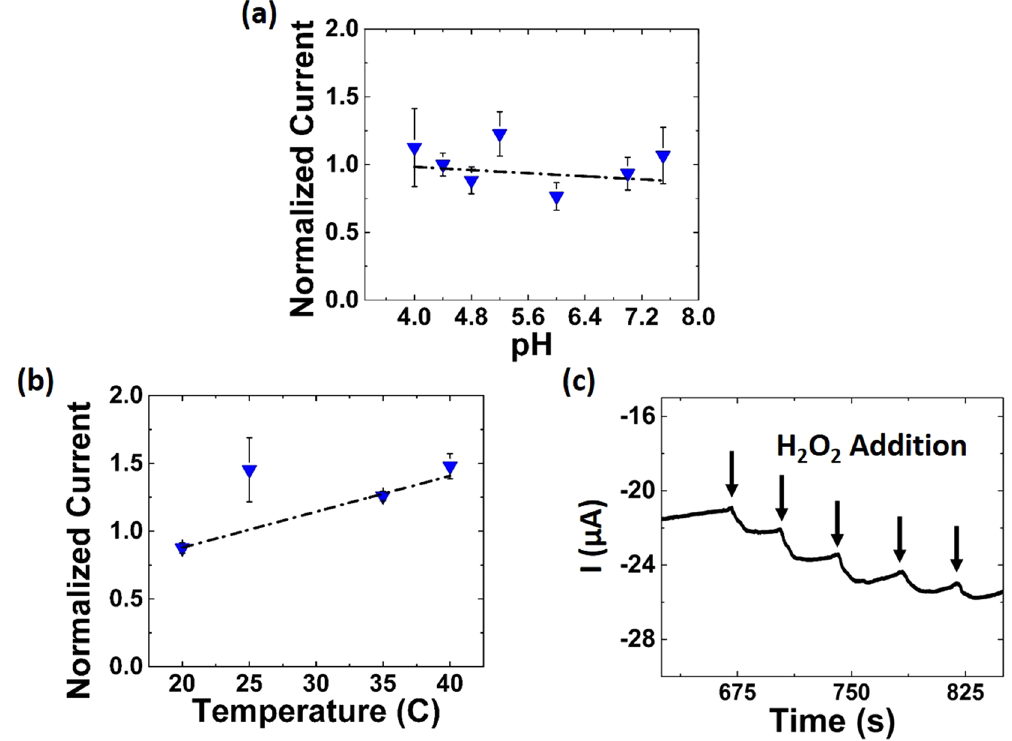
Figure 6. Sensing in harsh bio-conditions. The sensor shows no loss in activity from (a) pH 4.0 to 7.6 (st. dev: 27.3%) or from (b) 20 to 40 °C (st.dev: < 5%), as compared with HRP which loses significant activity across these ranges. Further, experiences a melting point at 42 °C resulting in loss of tertiary structure. (c) CA with Nafion-coated CNP-based sensor in blood serum. Serial additions of 1 μ M H 2 O 2 produces clear current signal suggesting absence of bio-fouling. Sensitivty in blood serum, after surface functionalization: 0.103 μ A/ log(M) * cm 2